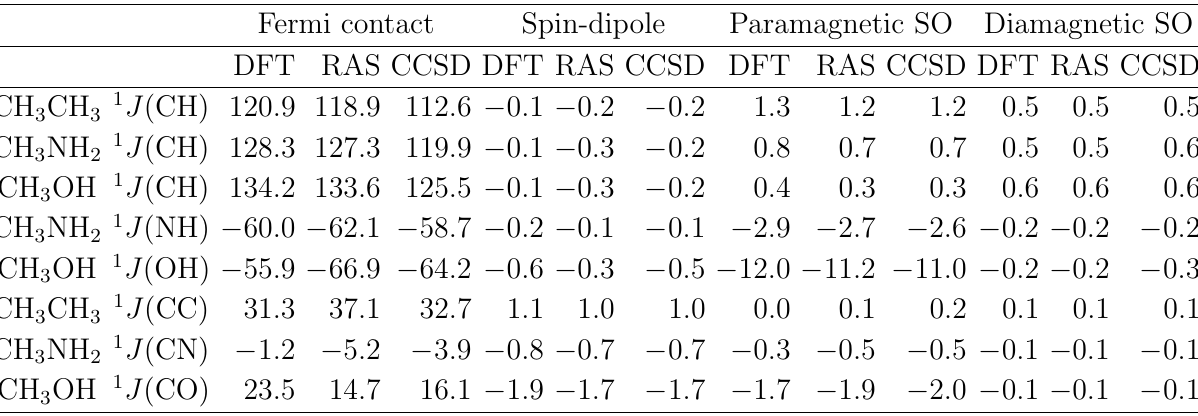
Table 2: Comparison of individual contributions to the one-bond coupling constants calculated at the DFT, RASSCF a and CCSD